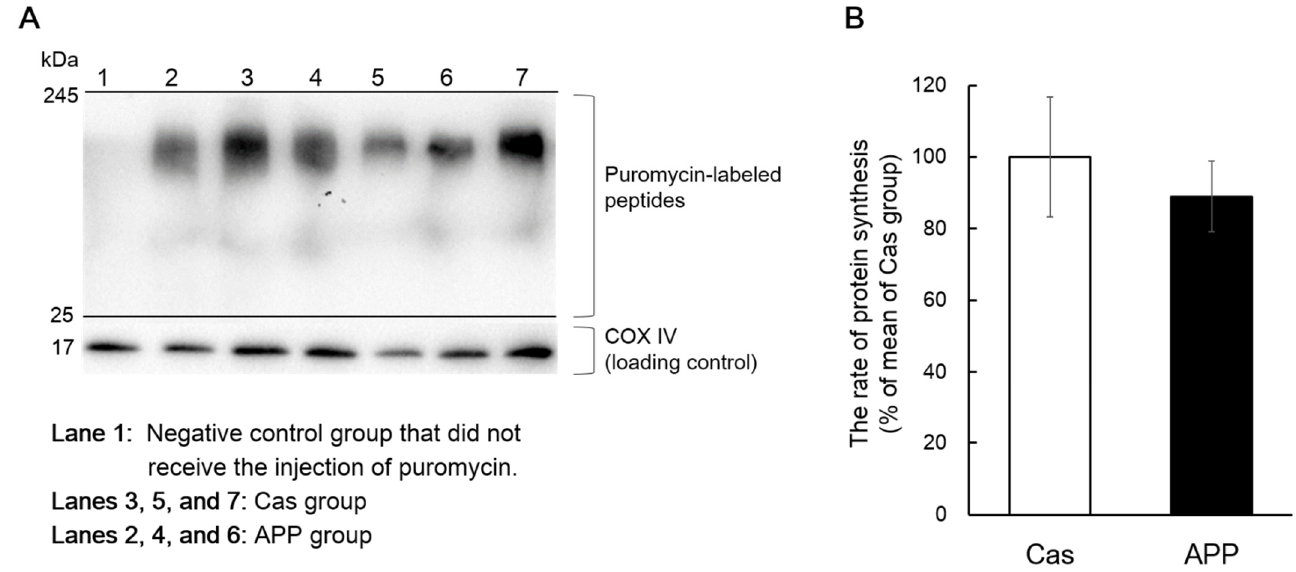
Figure 6. The rates of protein synthesis in the gastrocnemius muscle of rats fed a normal-fat casein diet or a normal-fat Alaska pollack protein (APP) diet after 2 days of feeding. Representative images of Western blot analysis for puromycin-labeled peptides are shown (COX IV is shown as a loading control) ( A ). The rate of protein synthesis in the gastrocnemius muscle of normal-fat casein diet group (Cas, n = 5) and normal-fat APP diet group (APP, n = 5) after 2 days of feeding are shown ( B ). Data are expressed as the mean ± standard error (SEM). Statistical analysis was performed using Student’s unpaired t